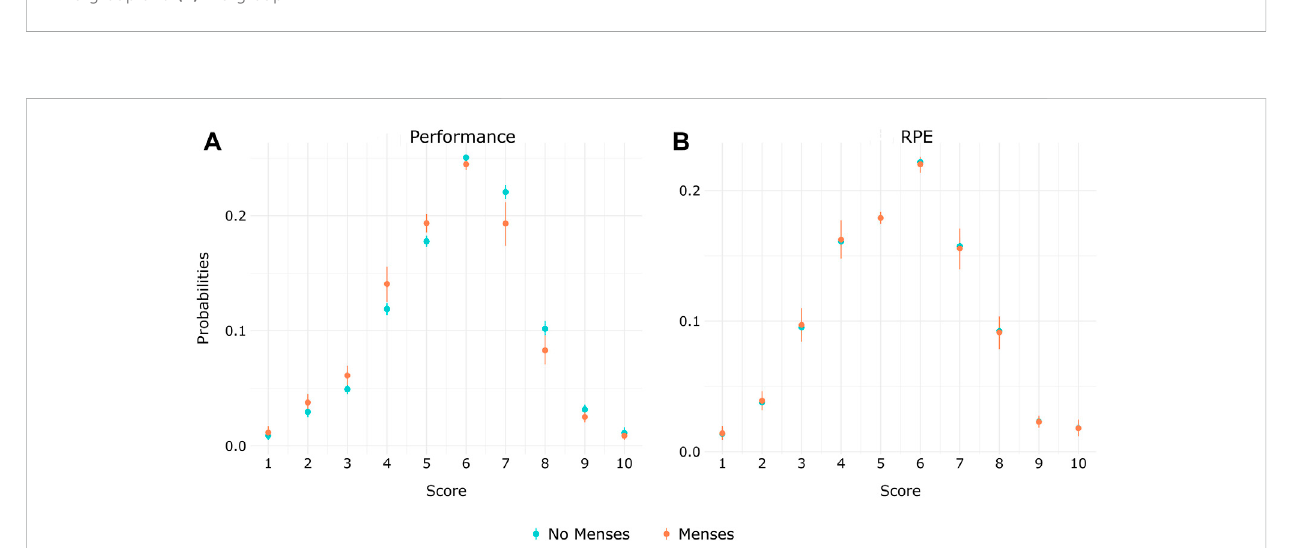
FIGURE 4 Probabilities among elite rowers of self-evaluating their daily training (A) Performance and (B) RPE from 1 – 10 according to the menstrual status (menses/no